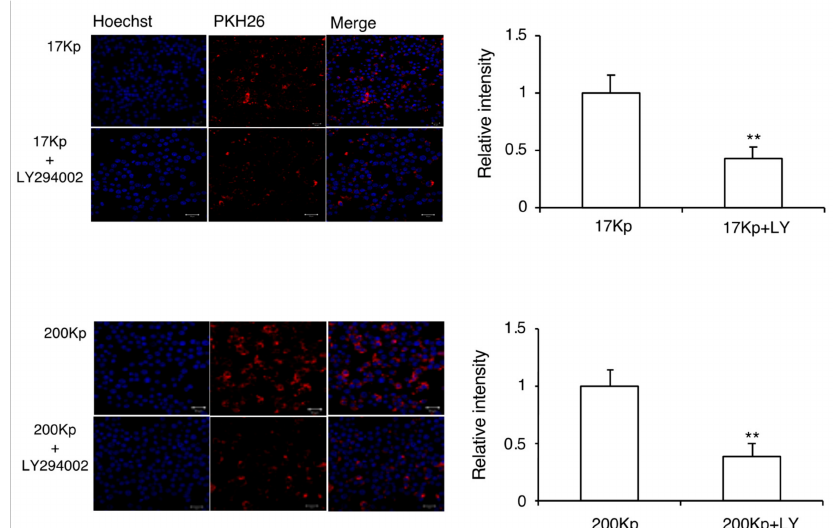
Figure 5. Effect of the macropinocytosis inhibitor on the intracellular incorporation of 17 Kp and 200 Kp into RAW264 cells. The 17 Kp or 200 Kp were stained with PKH26. Cells were treated with 50 µ M of LY294002 for 1 h, then 400 µ g protein/mL 17 Kp or 200 Kp for 2 h. Nuclei were stained with Hoechst33342. Cells were observed by confocal laser microscope. Asterisk indicates significant difference from the 17Kp or 200Kp group at ** p < 0.01.